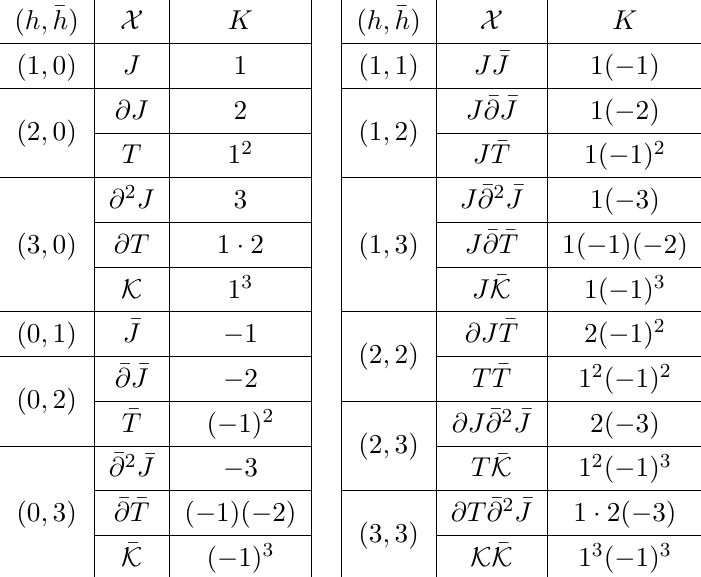
Table 1 . The correspondence of the CFT operators X with conformal weight ( h, ¯ h ) and harmonic chain states K . We show the holomorphic operators, the anti-holomorphic operators, and the examples of the operators that are products of the holomorphic and anti-holomorphic